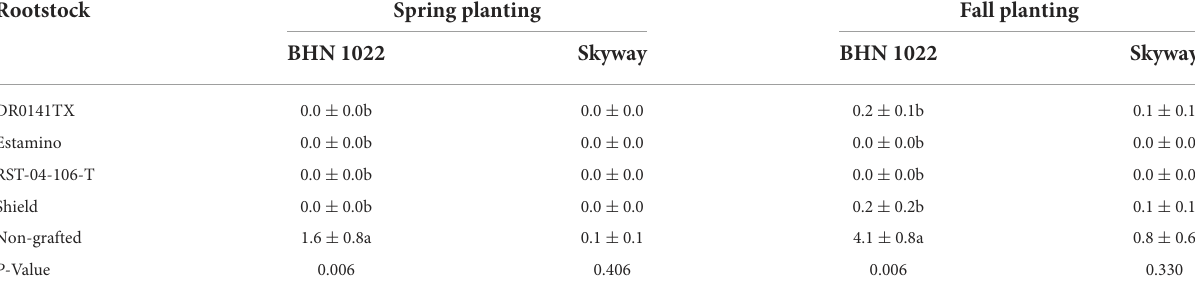
TABLE 11 Nematode galling index ratings (0–10 rating) of grafted beefsteak (‘Skyway’) and grape (‘BHN 1022’) tomatoes at plant termination as affected by rootstock and scion cultivars.